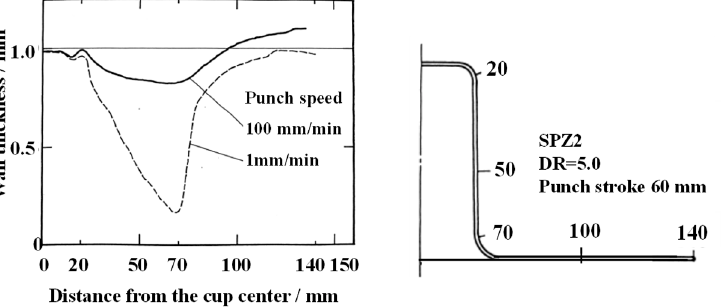
Figure 6. Comparison of wall thickness distribution of drawn cup at punch stroke of 60 mm under different SPDs (BHF = 2 kN, DR = 5.0). Left: thickness distribution. Right: measuring points on the drawn cup.